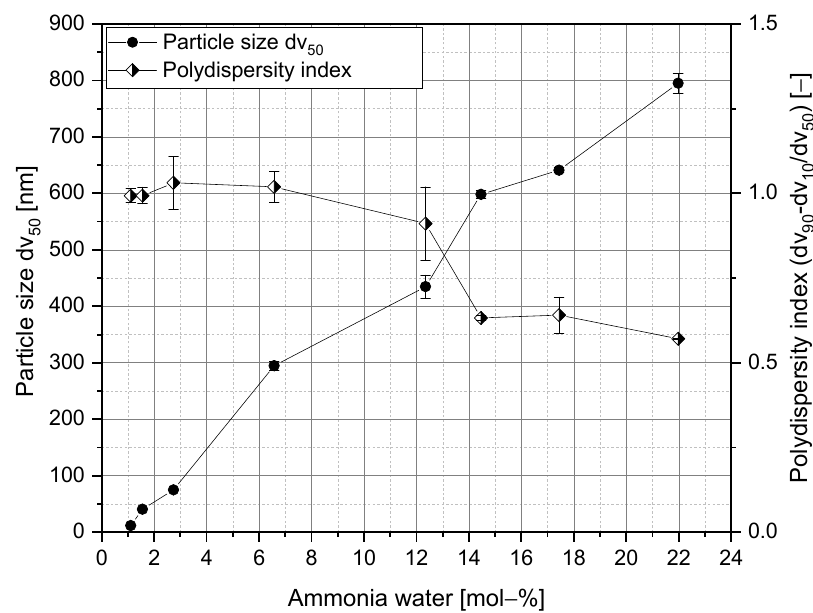
Figure 3. Particle size and polydispersity index of the silica nanoparticles by varying the amount of ammonia when using the Stöber method.